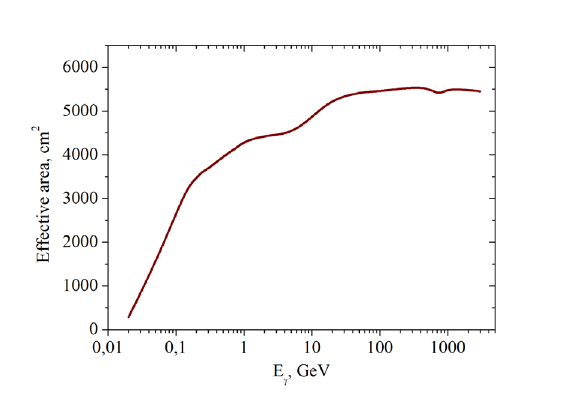
Figure 3. The dependence of the e ff ective area vs the energy for vertically incident